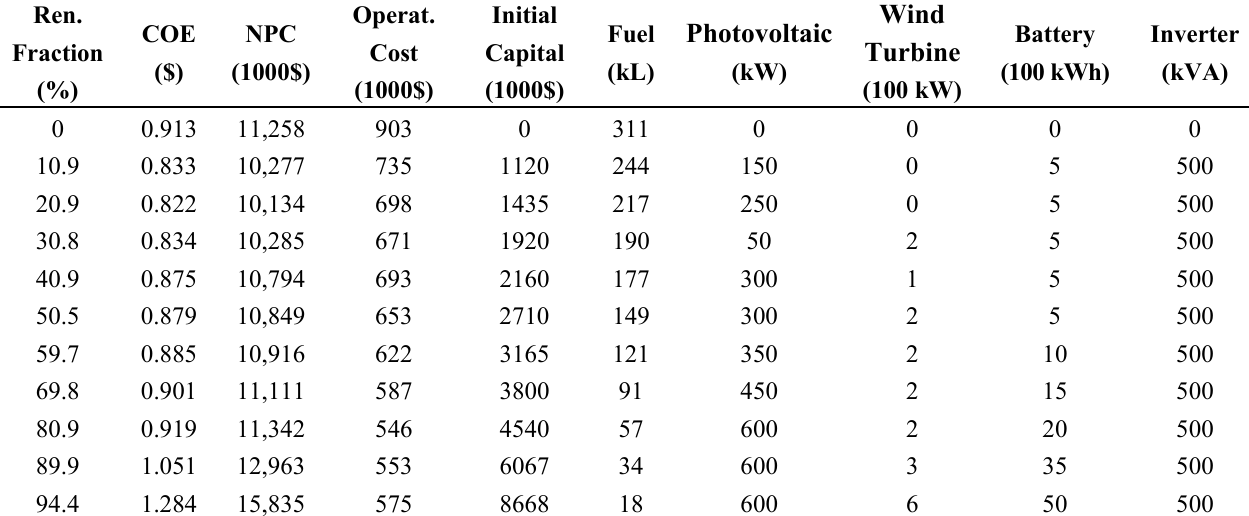
Table 3. Simulation result for economic feasibility